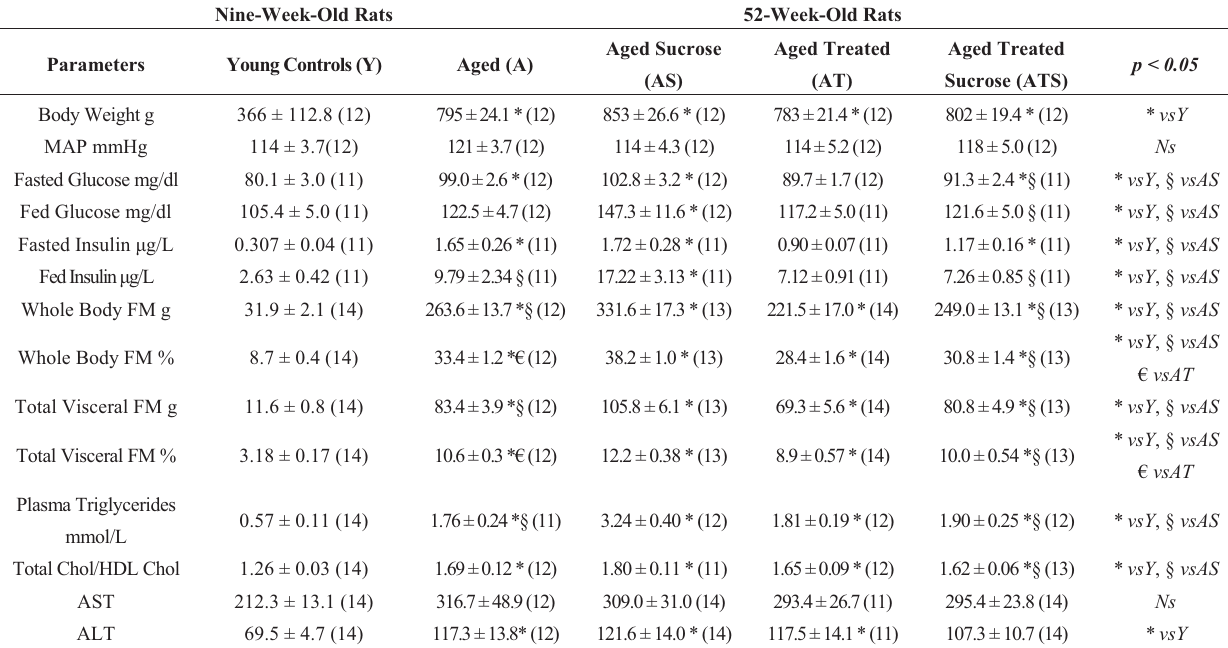
Figure 2. The effects of age ± sucrose supplementation and SAMEC protection on HISS and insulin action. HISS and insulin action determined from the RIST in young (Y), 52-week-old or aged (A) rats, aged rats supplemented with sucrose (AS), and ± SAMEC protection. Aging to one year decreased both HISS action and insulin action. Sucrose supplementation further aggravated the conditions in aged rats. The proportion of glucose disposal attributed to insulin increased to 91% of the total, as HISS action declined in the AS group. The SAMEC treatment (ATS) conferred protection of HISS action. * p < 0.05; ** p < 0.01; *** p < 0.001. Table 1. Physical and metabolic parameters in young and aged ± sucrose-supplemented and SAMEC-treated